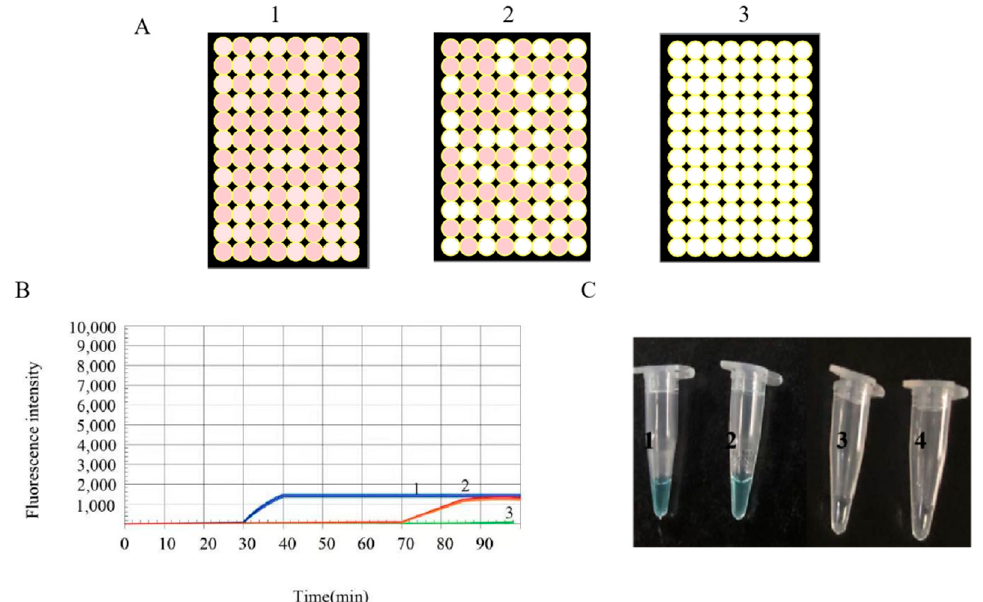
Figure 6. ( A ) RT-LAMP-BART bioluminescent well images obtained when utilizing an optimized BART reagent mixture. 1 and 2 meant the target RNA template concentration from 10 4 to 10 3 copies/mL. 3 meant the negative control sample. Positive wells from 1 to 3: 96, 60, 0. Negative wells from 1 to 3: 0, 30, 96. The total well wells from 1 to 3: 96, 96, 96. ( B ) The same samples in ( A ) were tested by qPCR. ( C ) The same samples in ( A ) were tested via a colorimetric kit, wherein blue and clear correspond to positive and negative, respectively. The negative control sample was derived from the SARS-CoV-2 Orf1ab Visual RT-LAMP Kit.